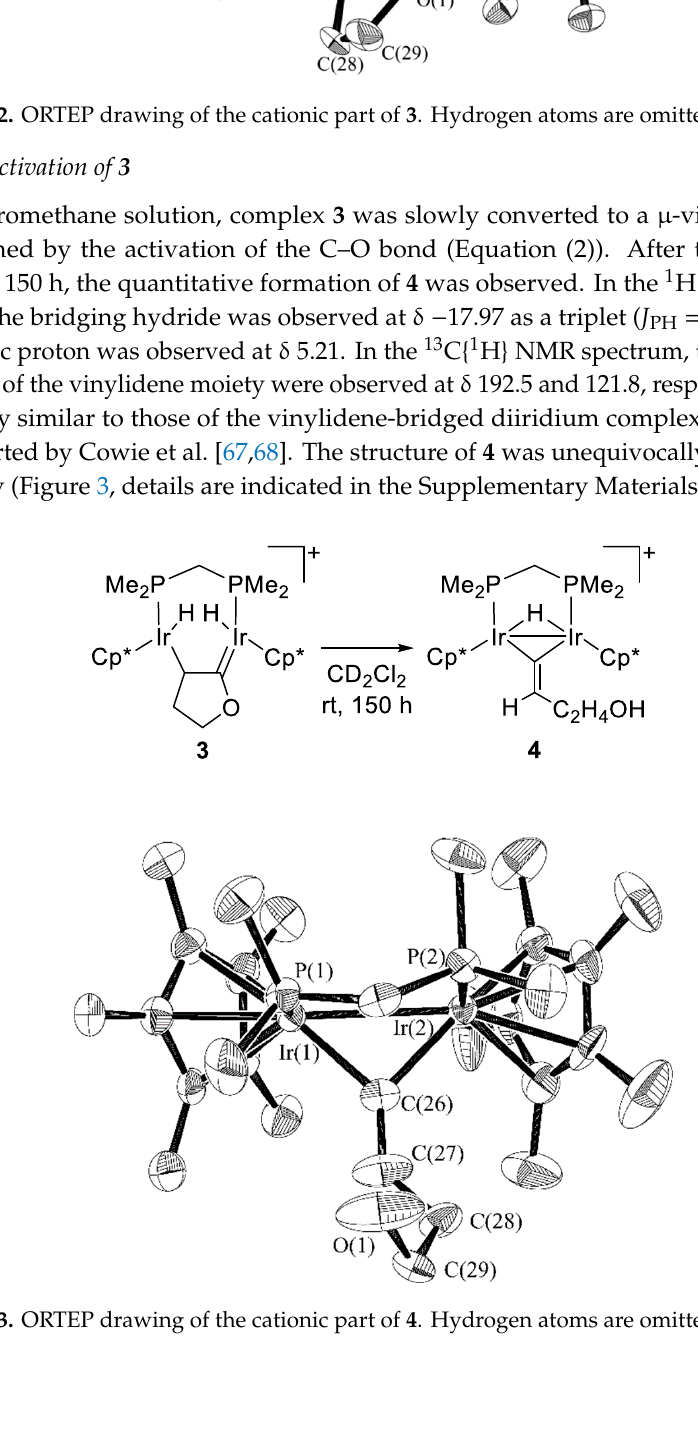
Figure 2. ORTEP drawing of the cationic part of 3 . Hydrogen atoms are omitted for clarity.